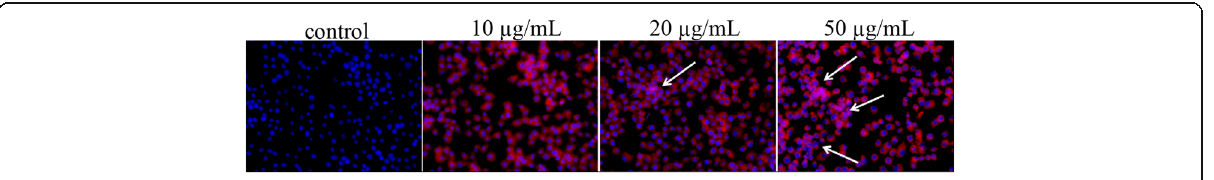
Fig. 9 DNA damage of MCF-7 cells after Pp IX